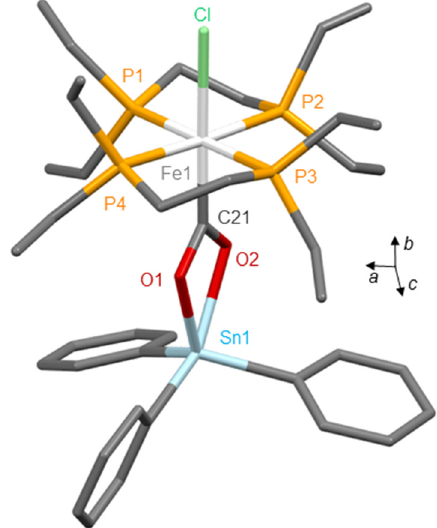
Figure 25. Molecular structure of 26 , adapted from [79] (MERCURY view). Hydrogen atoms are omitted for clarity (Sn light blue, O red, P orange, Cl light green, Fe white, C grey).